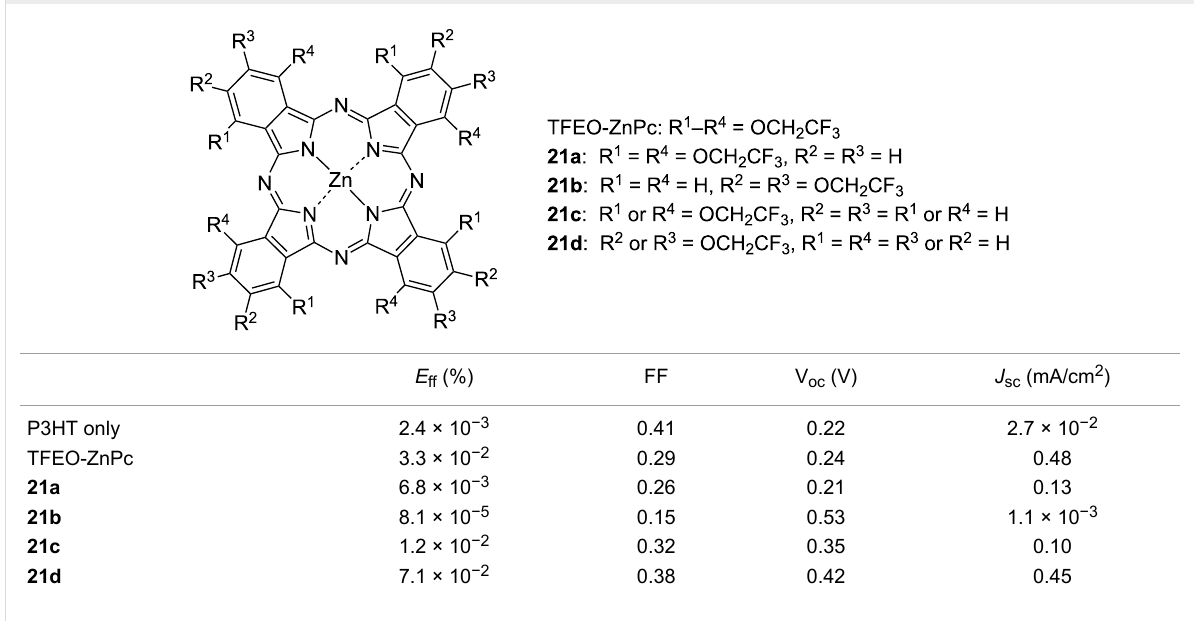
Table 3: Characteristics of phthalocyanine/P3HT heterojunction organic thin-film solar